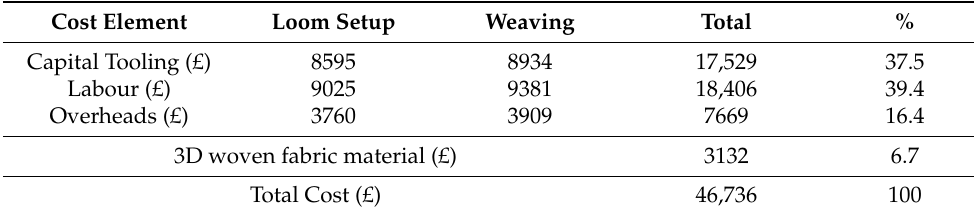
Table 7. Estimated cost of 3D woven fabric, 14 preforms.